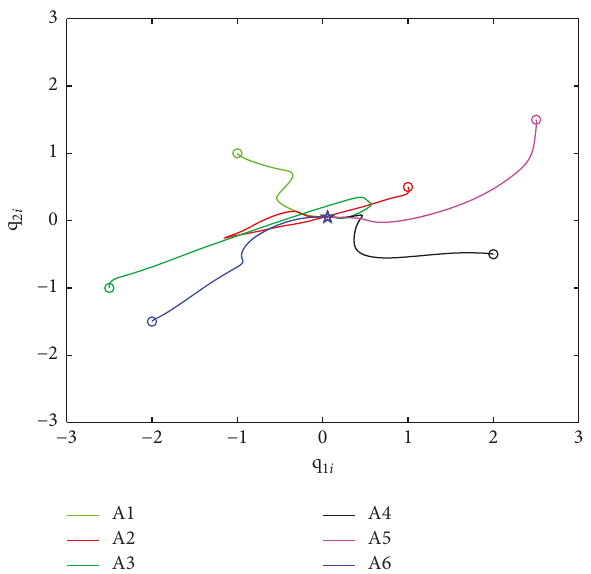
and τ and the fault-free case (AFSC). 1 i 2 i